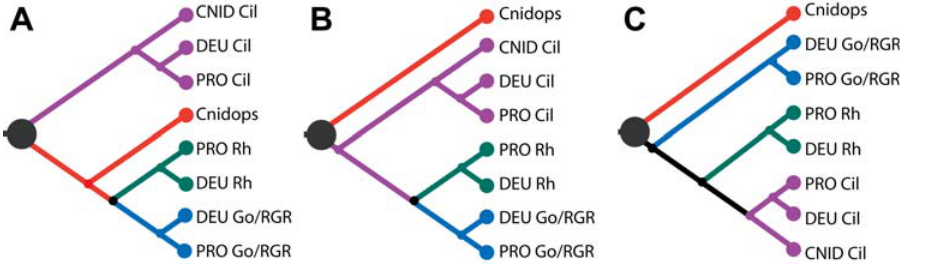
Figure 4. Three hypotheses for metazoan opsin relationships. These are statistically indistinguishable when considering only the likelihood of observed amino acid sequences. (A) Our preferred phylogenetic hypothesis where ciliary opsins are an outgroup to other opsin clades and cnidops is the sister to the rhabdomeric + G o clade. This hypothesis minimizes the number of gene duplication and loss events required to explain the evolutionary history of metazoan opsins and is consistent with morphological data [33]. (B and C) Phylogenetic hypotheses in which cnidops represents the outgroup to other opsins. Given our finding of a ciliary opsin in Nematostella , these hypotheses require the additional loss of ciliary opsin in the Hydra lineage and an additional loss of cnidops in bilaterian animals.